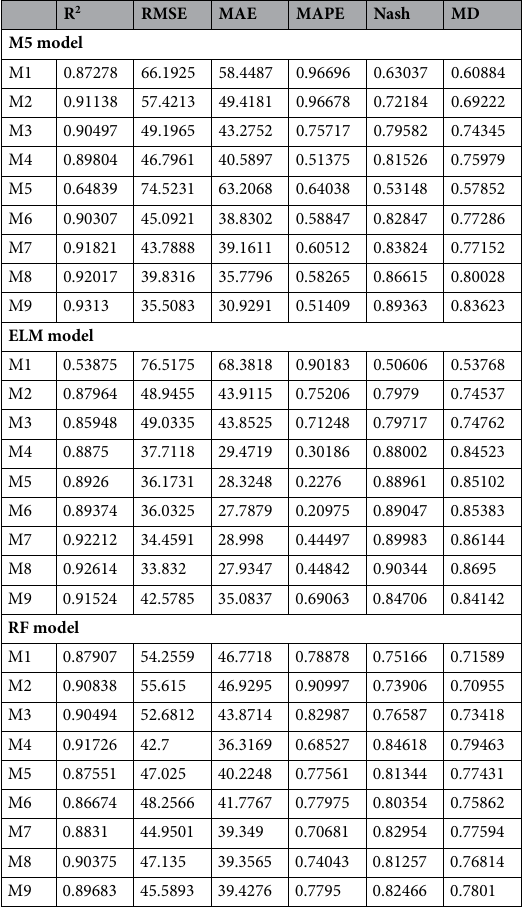
Table 5. Statistical performance validation for testing